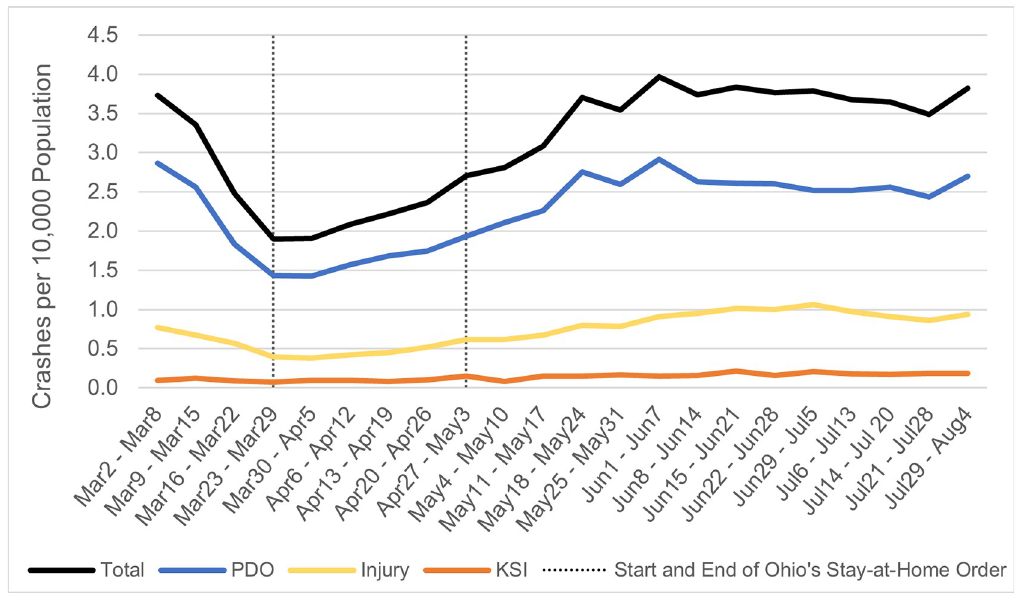
Fig 2. Crash rates in Ohio per week from March to August, adjusted for